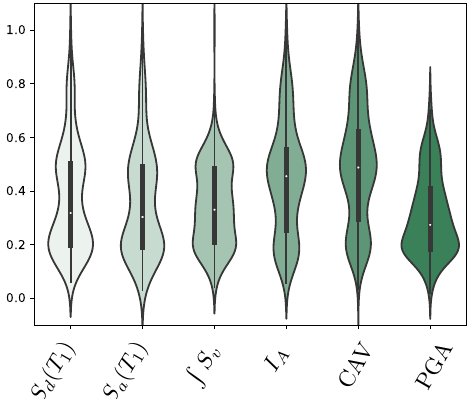
Figure 13. Violin plots [52,53] show the distribution of the intensities, which are used as inputs for the neural network; 291 samples are chosen as training data based on the proposed strategy using the shown six intensities with 5 bins